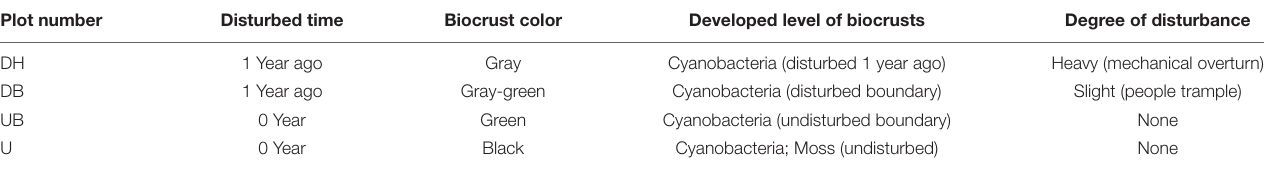
TABLE 1 | Basic characteristics of experimental plots.